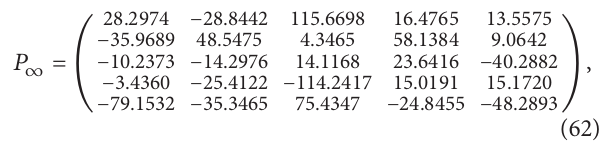
Figure 12: Trajectories of 𝜙(𝑡) = √−𝑥(𝑡) 𝑇 (𝐴 − 𝐴 𝑇 ) 2 𝑥(𝑡)/4𝑥(𝑡) 𝑇 𝑥(𝑡) and 𝜓(𝑡) = 𝑥(𝑡) 𝑇 (𝐴 𝑝 𝑝 𝐴 𝑇 )𝑥(𝑡)/2𝑥(𝑡) 𝑇 𝑥(𝑡) based on (10) with initial 𝑥(0) as (65), which 𝑝 should converge to |𝑏 2 | and 𝑎 2 , respectively.